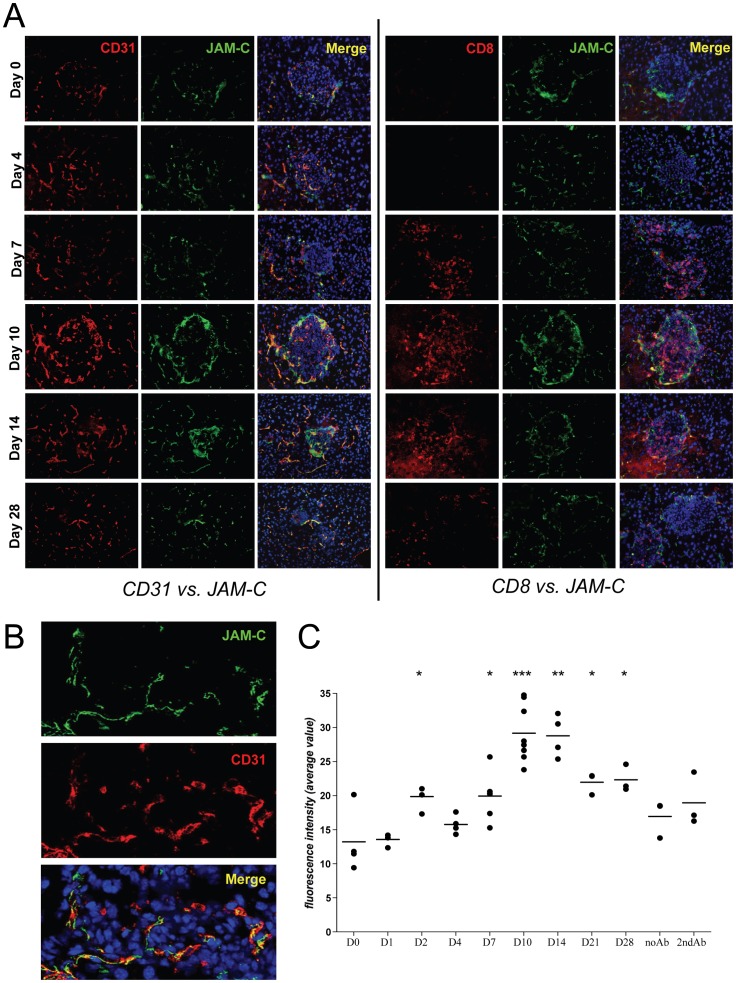
Expression of JAM-C after LCMV-infection.– (A) Pancreas sections of RIP-LCMV-GP mice were analyzed for expression of CD31 (red) and JAM-C (green) as well as CD8+ T cell infiltrations (red) and JAM-C (green) at different times after LCMV-infection. (B) JAM-C expression (green) predominantly co-localized with the endothelial cell marker CD31 (red) as shown in higher magnification in a representative pancreas section from a RIP-LCMV-GP mouse at day 10 post-infection. (C) Evaluation of fluorescence intensity of JAM-C expression at different times after LCMV-infection. Bars representing mean of 3–8 islets each time point and statistical significance of the fluorescence intensity relative to day 0 were determined using the unpaired t test (*, p<0.05; **, p<0.005; ***, p<0.0005).